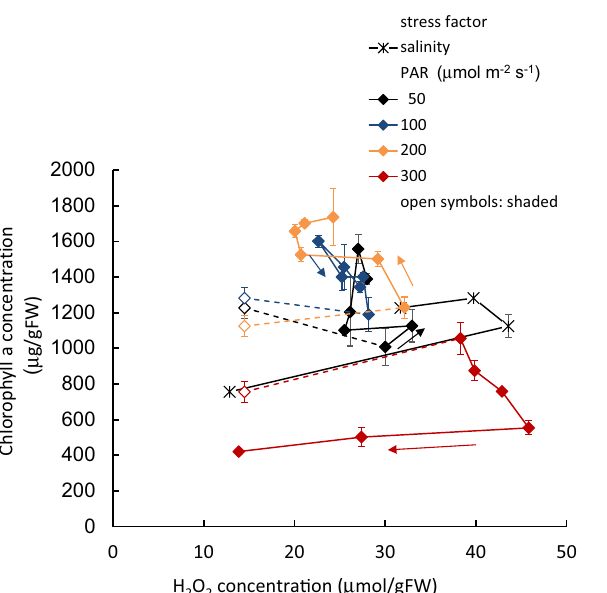
Figure 6. Chl- a concentration of tissues with respect to the H 2 O 2 concentration. Dashed lines indicate the starting dark condition to the exposure of each PAR intensity, and straight lines indicate the variation due to the experimental